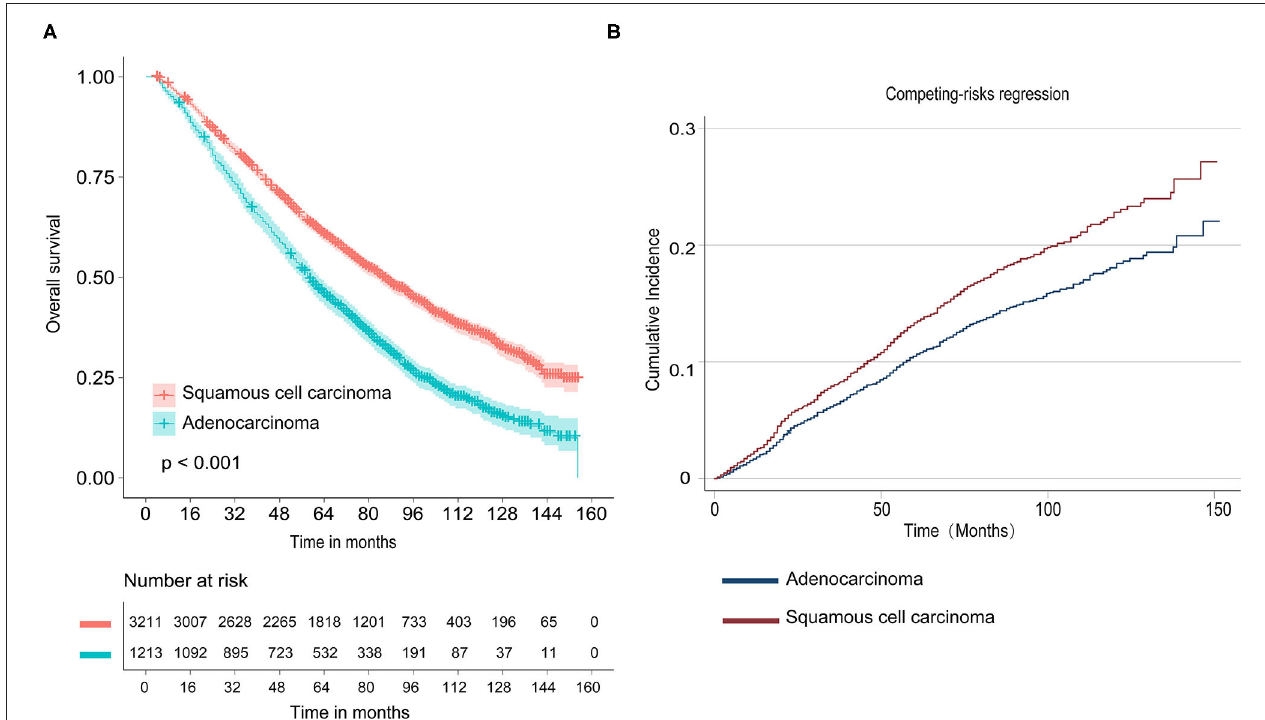
FIGURE 1 | Survival analyses for stage nonsmall-cell lung cancer (NSCLC) patients with tumor size ≤ 20mm. (A) Kaplan–Meier estimates for overall survival by histological subtype; (B) Cumulative incidence for lung cancer-specific mortality by histological subtype.